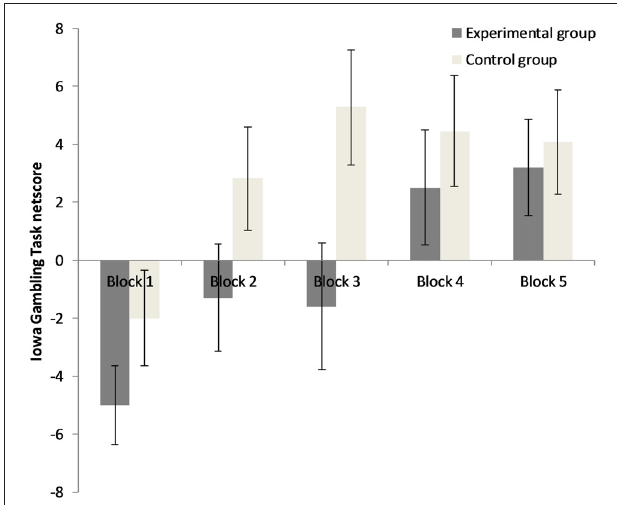
FIGURE 3 | Decision-making performance in both groups for the five blocks of 20 trials. Error bars represent ± one standard error of the